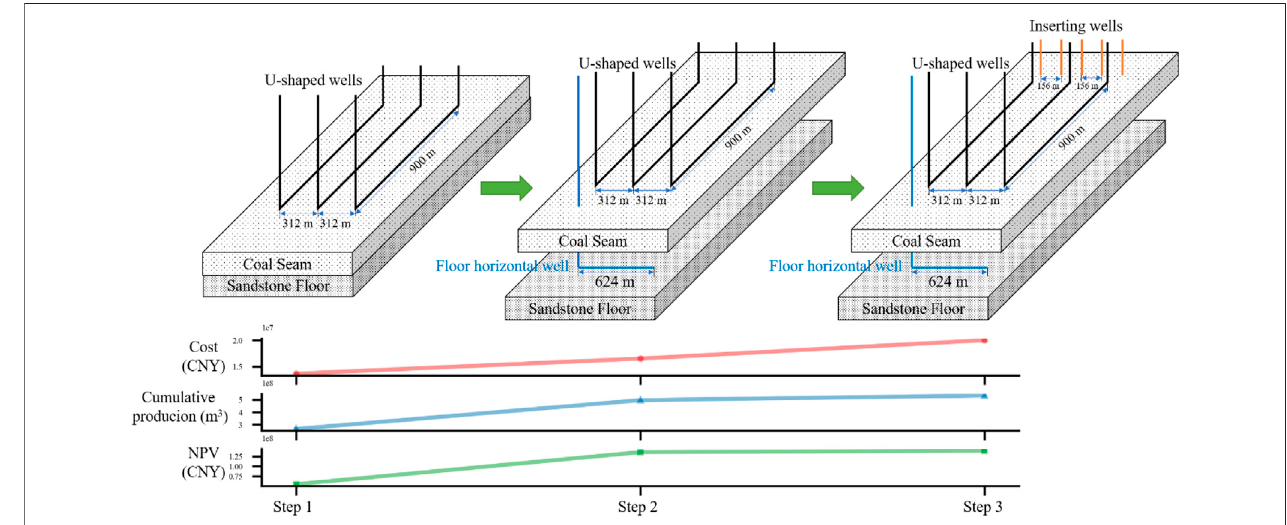
FIGURE 14 | Optimization process and result statistics of well pattern in the high-dip coal seam.